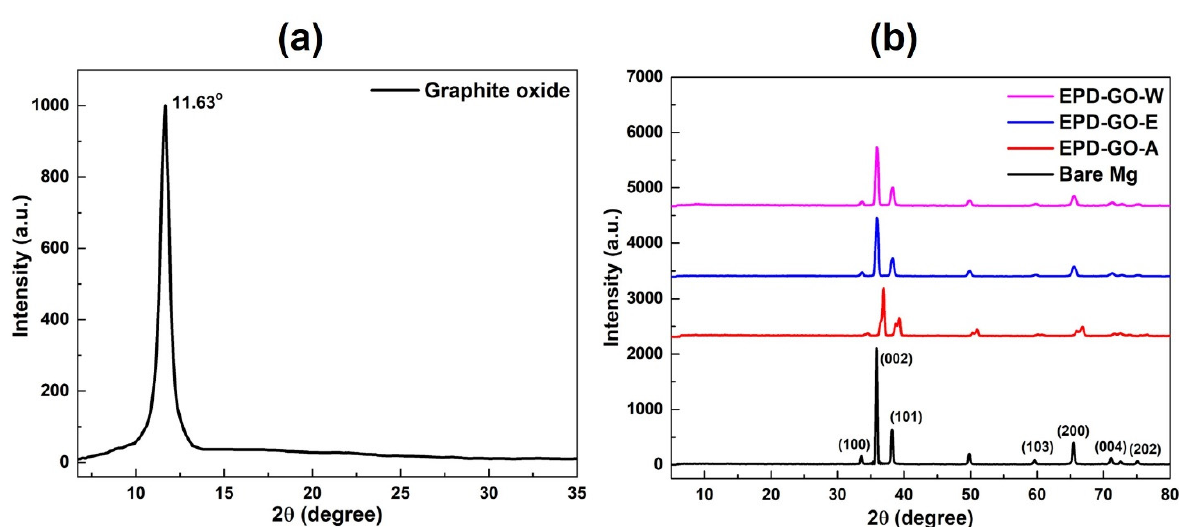
Figure 1. XRD pattern of ( a ) graphite oxide and ( b ) uncoated and EPD-GO-coated Mg